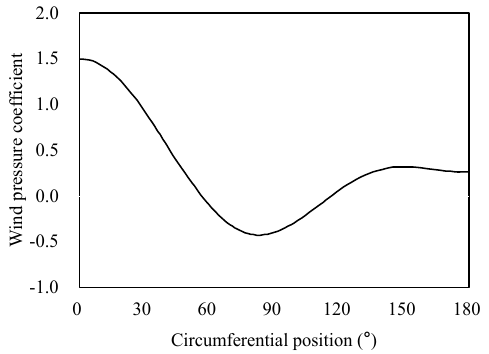
Figure 3. Applied wind pressure coefficients for the 100,000 m 3 steel tank.